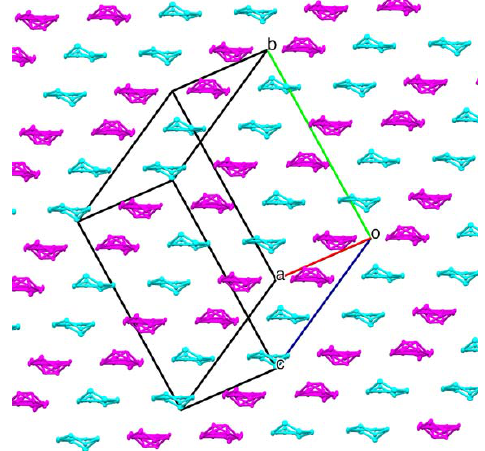
Figure 2. Conducting BEDT-TTF radical cation layers of salts 1 – 5 packed by β ″ -type. Crystallographically unique BEDT-TTF radical cations are denoted by color. Molecule A is colored magenta, B is colored cyan. AABBAABB packing arrangement for BEDT-TTF stacks and chains is